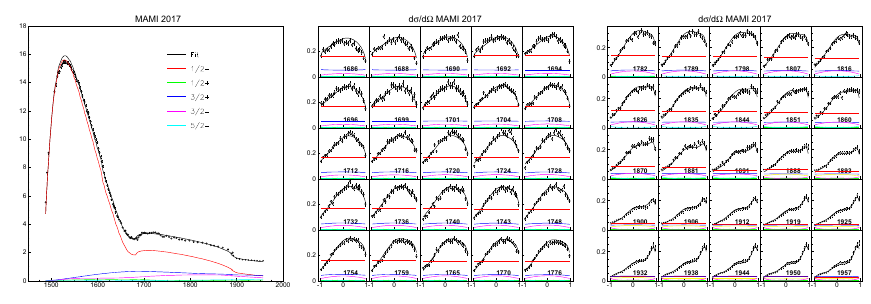
Figure 1. Description of the γ p → η p di ff erential cross section from A2 collaboration [7] and contri- bution of the leading partial waves.